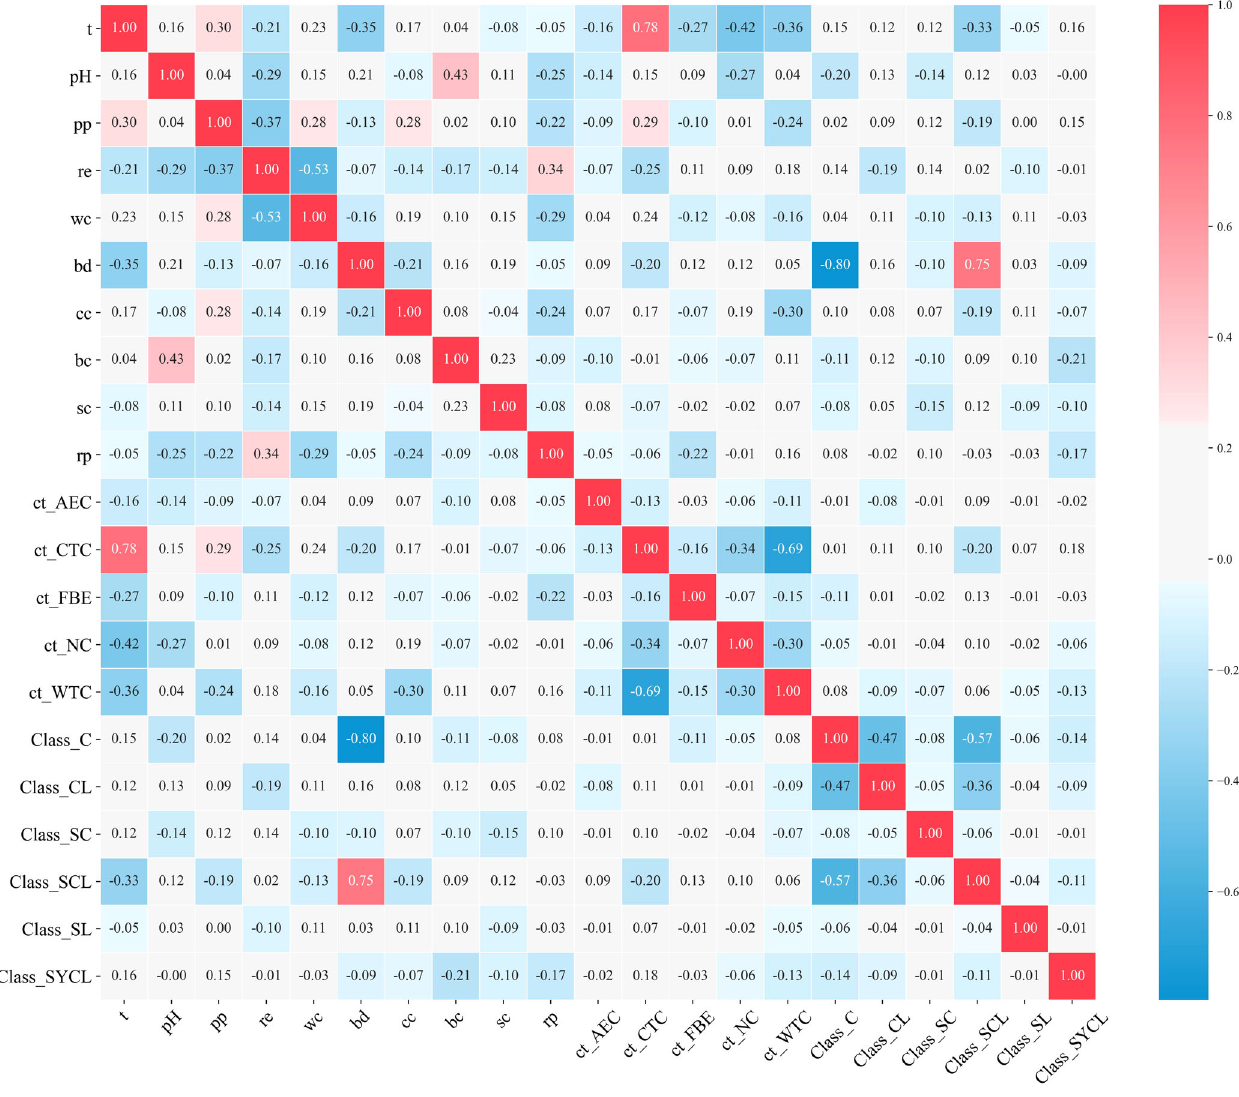
Fig. 4 Matrix of the Spearman correlation coef fi cients between the different features. Strongly correlated (>0.7) features indicate the presence of redundant variables, which guide the screening of features.